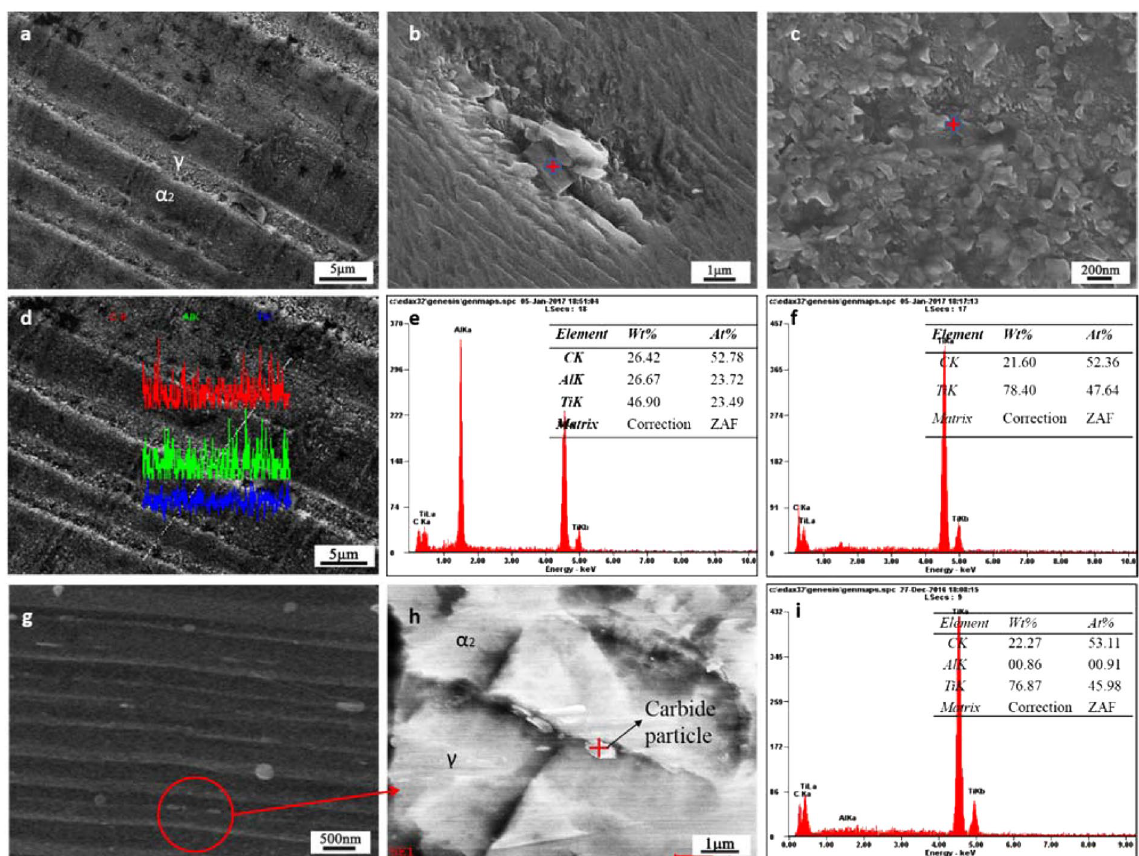
Figure 2. Microstructure and EDS patterns of CFGRTAC remelted for the first time. ( a ) SEM image of CFGCRTAC remelted; SEM images of ( b ) cuboid reinforcement, ( c ) spherical reinforcement, ( d ) EDS element line scanning patterns of the lamellar structure, EDS patterns of ( e ) cuboid reinforcement and ( f ) spherical reinforcement, SEM image of ( g ) the lamellar structure and ( h ) the magnification of interface in TiAl matrix; ( i ) EDS patterns of particle in the lamellar interface of TiAl